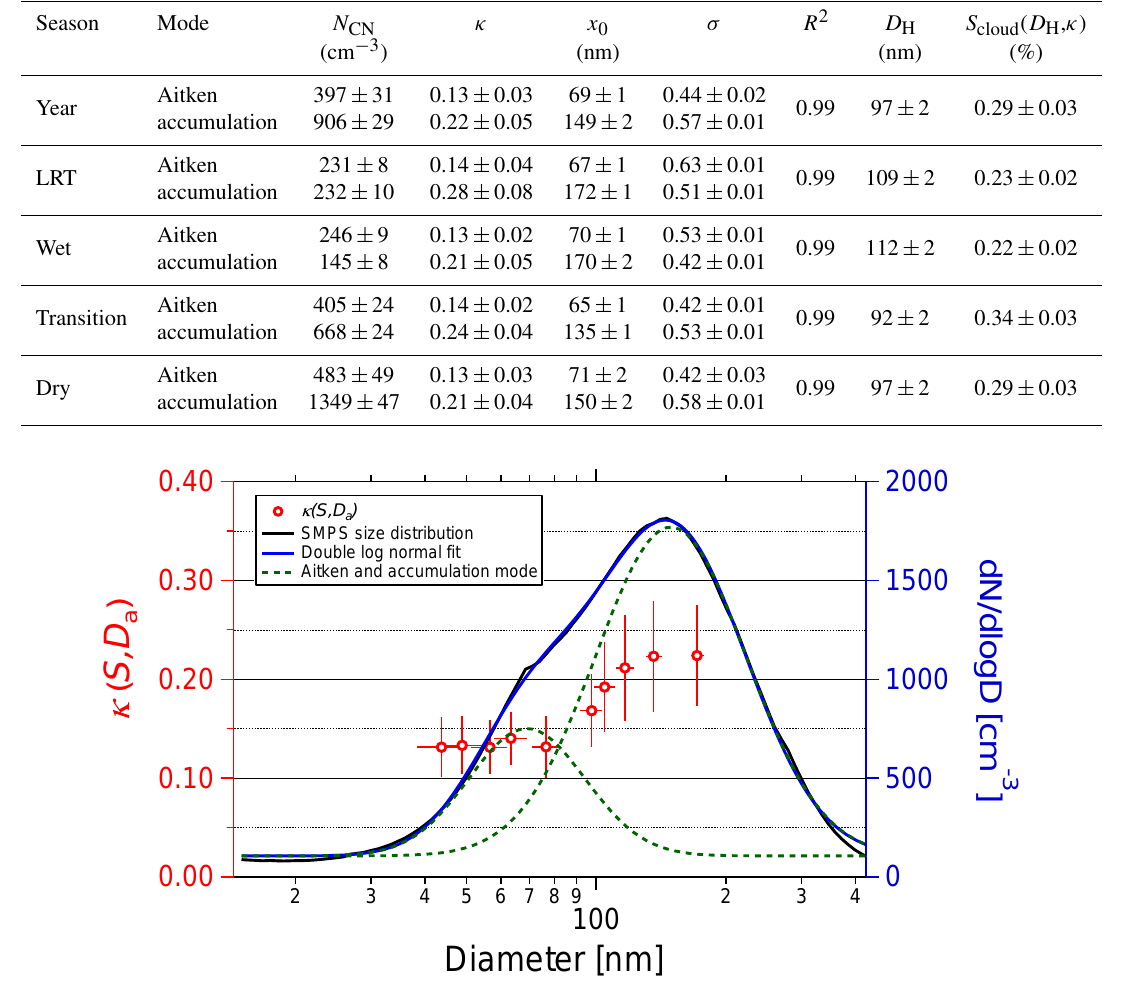
Table 2. Properties (position x 0 , integral number concentration N CN , width σ) of Aitken and accumulation modes from the double log- normal fit (compare to R 2 ) of the total particle size distributions. Values are given as annual means and subdivided into seasonal periods of interest as specified in Sect. 3.3 (compare also to Fig. 6). In addition, values for the position of the Hoppel minimum D H as well as estimated average peak supersaturation in cloud S cloud ( D H , κ) are listed. The errors represent the uncertainty of the fit parameters. The error in S cloud ( D H , κ) is the experimentally derived error in S .